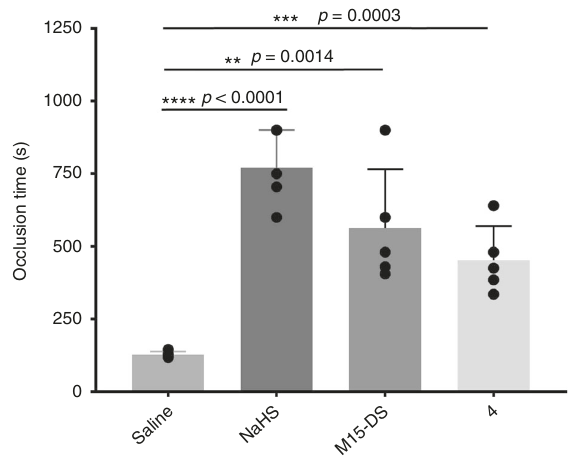
Fig. 6 In vivo antithrombosis studies. Both the clinical H 2 S donor and the model H 2 S donor demonstrated inhibition to injury-induced thrombosis occlusion in mice (data is displayed as mean ± S.E.M., n =